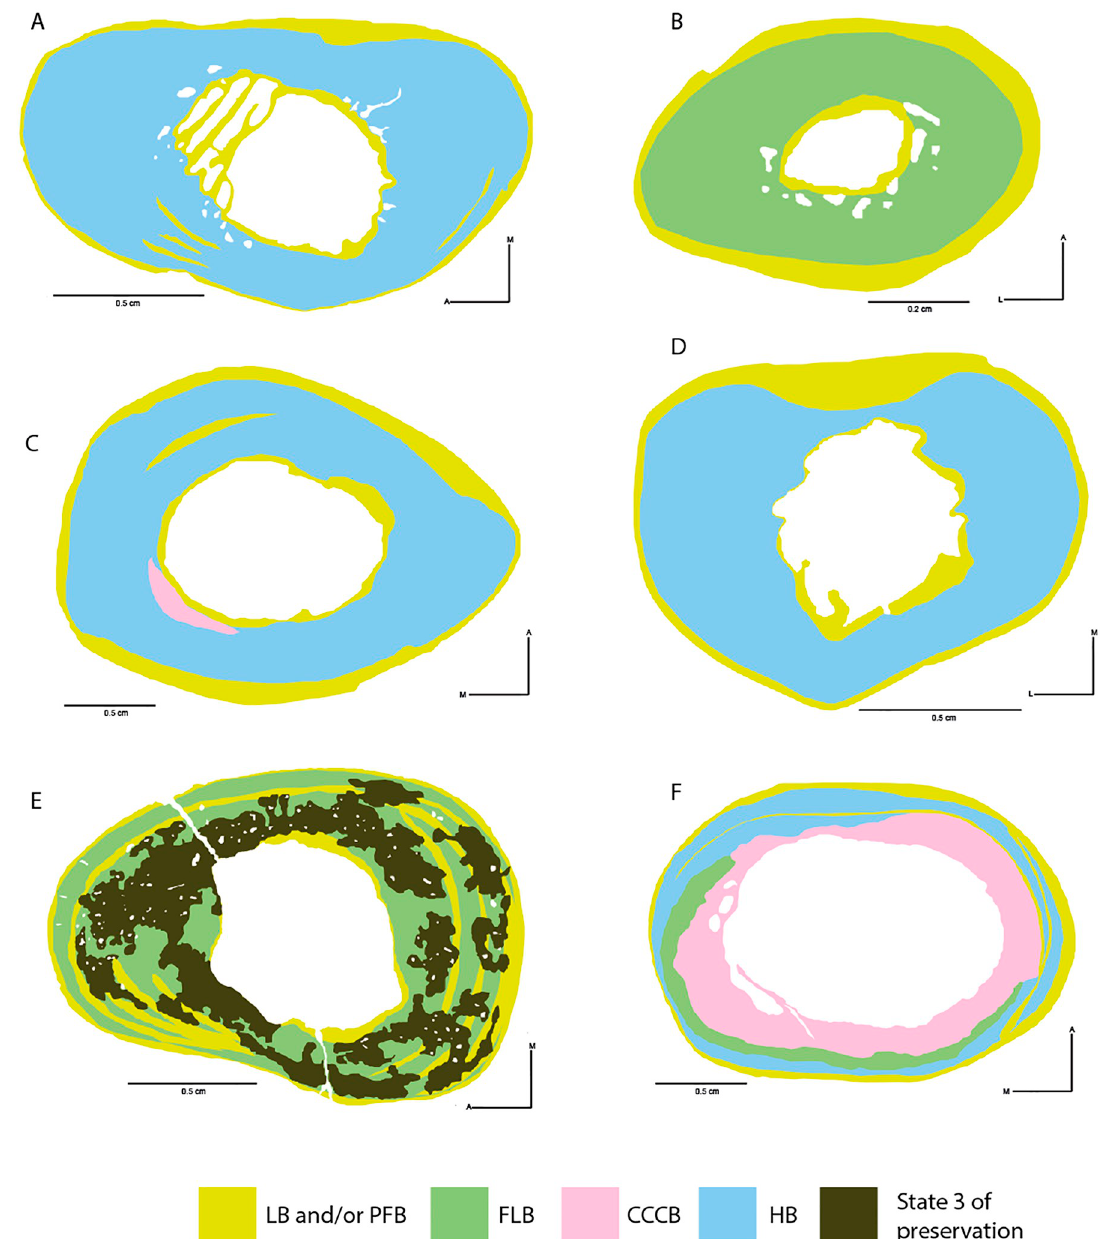
Fig 12. Types of bone tissue in section of Caraguatypotherium munozi from the middle Miocene of Caragua, Huaylas formation. Individual 4 (HUAY16-100): A and B, Individual 5 (HUAY15-84): C and D, Individual 6 (HUAY15-027): E, Individual 7 (HUAY17-02): F. (A) Left tibia (GEOUACH.HS.TI.1); (B) Left metatarsal II (GEOUACH.HS. MTSI.1); (C) Left femur (GEOUACH.HS.FI.2); (D) Left tibia (GEOUACH.HS.TI.1); (E) Left tibia (GEOUACH.HS.TI.3); (F) Right femur (GEOUACH.HS.FD.1). For abbreviations refer to Fig